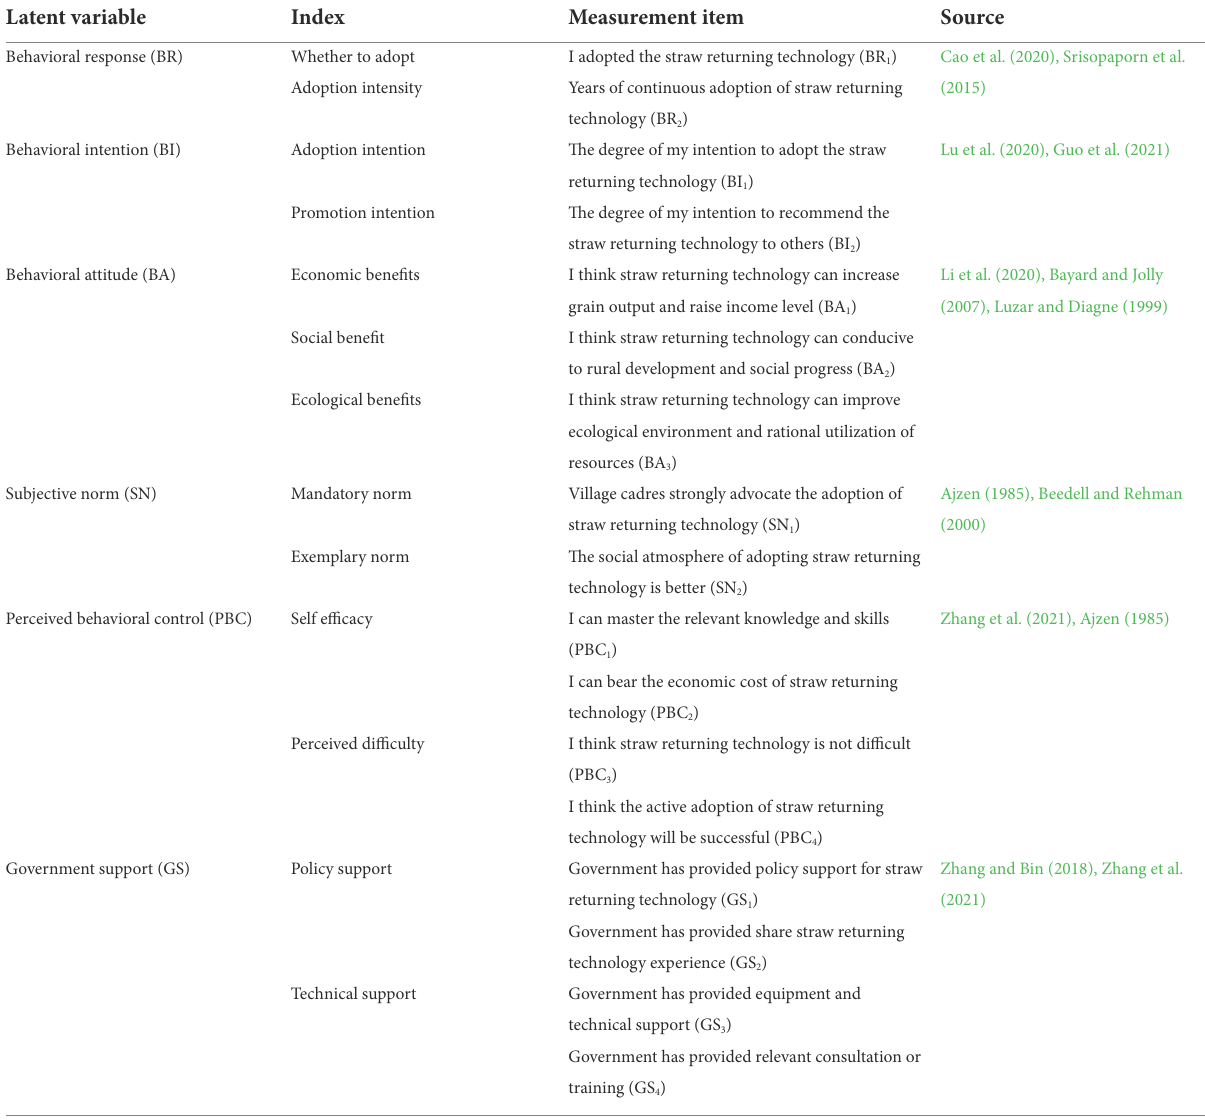
TABLE 2 Variable definition and measurement